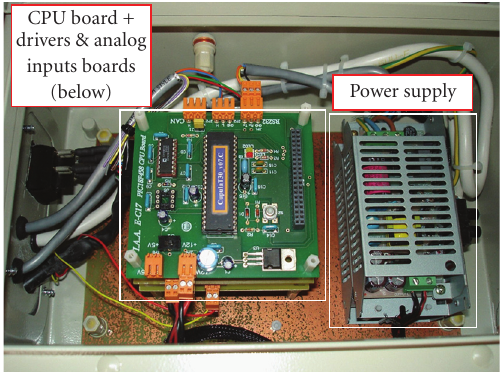
Figure 5: Photograph showing part of the system hardware. Red text show elements developed and described in this work.